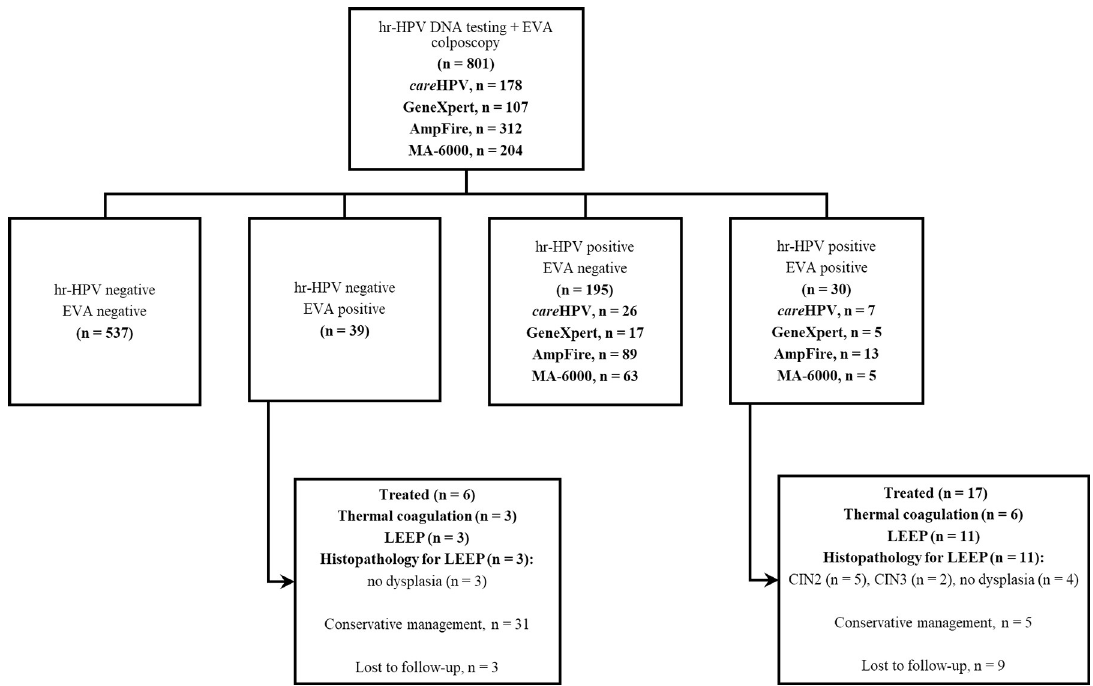
Fig 2. Flow chart for concurrent screening with hr-HPV DNA testing and EVA colposcopy. hr-HPV, high-risk human papillomavirus; LEEP, loop electrosurgical excision procedure.